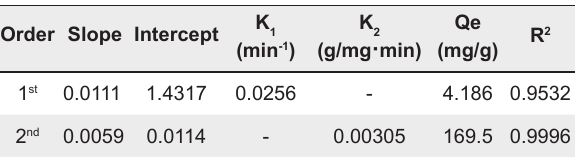
Table 2. The order and rate constants for the adsorption of I on to ASL-2. 2 Order Slope Intercept